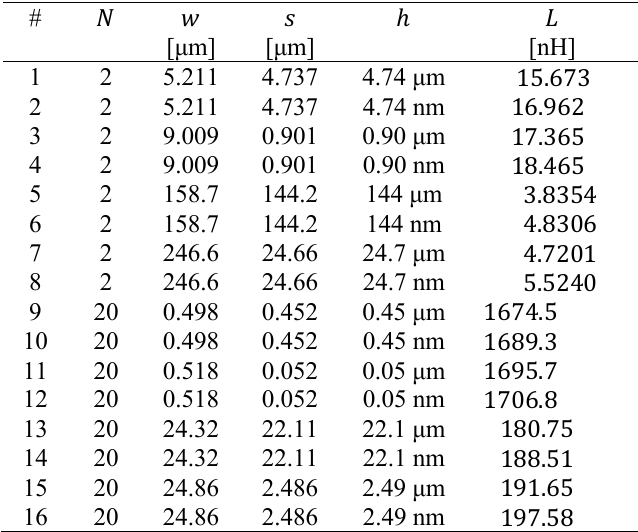
Table 2: Same as Table 1, but with the approximate values of the corresponding dimensional parameters, numbered in the same order.